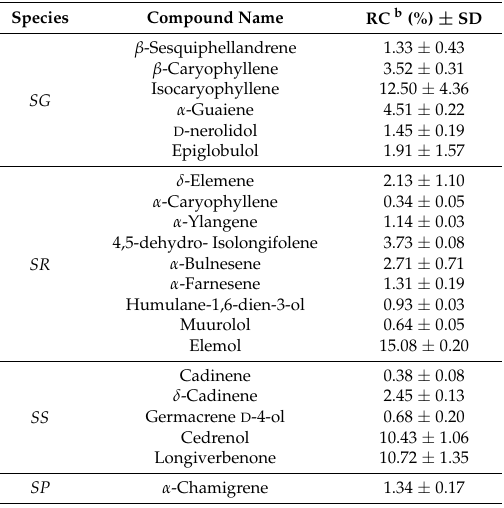
Table 2. The particular components of sesquiterpenes and oxygenated sesquiterpenes of four species of Schisandra